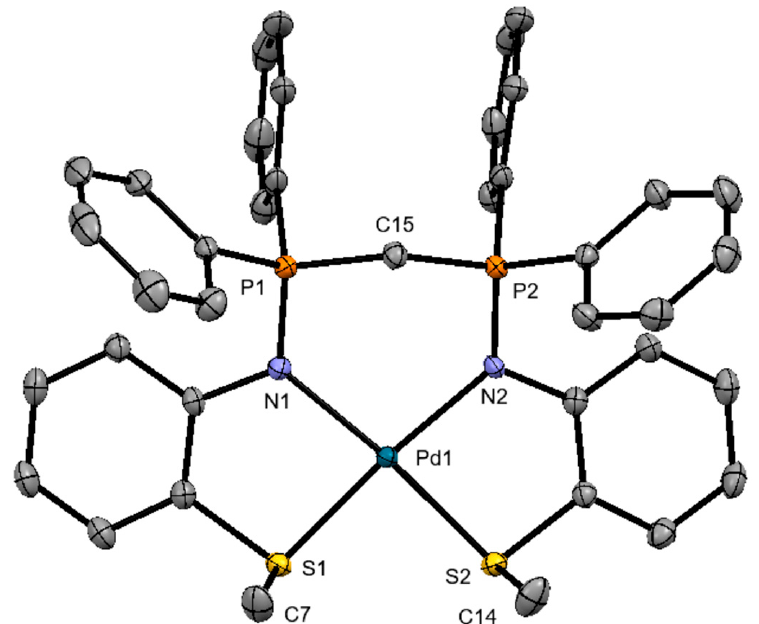
Figure 2. ORTEP drawing of complex 5 with thermal ellipsoid plot shown at 50% probability level. Solvent molecules, PF 6 − anions and hydrogen atoms have been omitted for clarity. Selected bond distances (Å) and angles ( ◦ ) for 5 : Pd(1)-N(2) 2.079(2), Pd(1)-N(1) 2.074(2), Pd(1)-S(1) 2.266(6), Pd(1)- S(2) 2.268(6), P(2)-N(2) 1.619(2), P(1)-N(1) 1.616(2), N(2)-Pd(1)-S(1) 172.1(6), N(1)-Pd(1)-S(2) 173.7(6), N(1)-Pd(1)-N(2) 100.6(8), N(1)-Pd(1)-S(1) 84.5(6), S(1)-Pd(1)-S(2) 89.9(2), S(2)-Pd(1)-N(2)